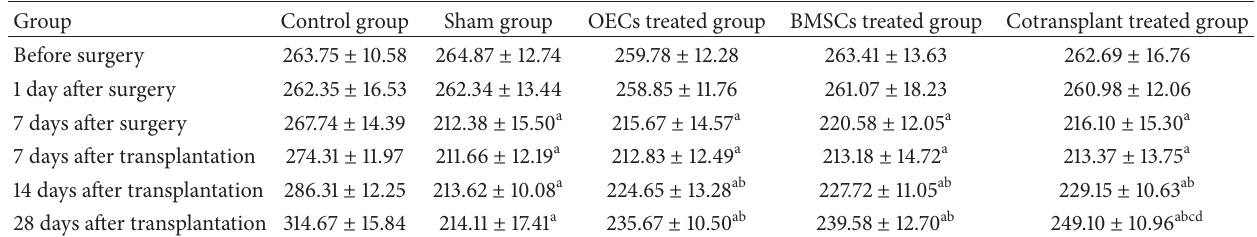
Table 1: The change of body weight for rats after surgery (g, 𝑥 ±